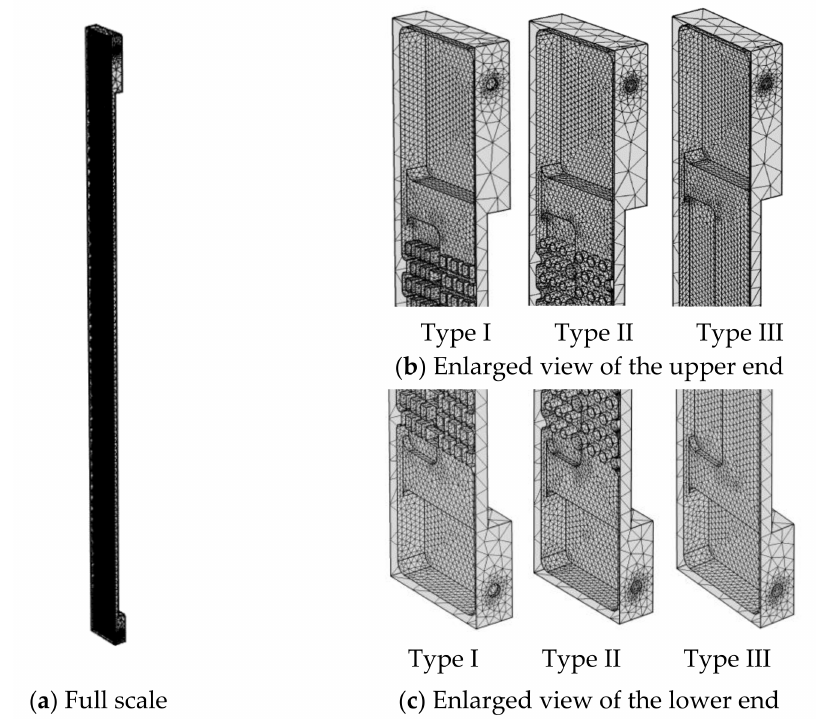
Figure 5. Internal meshes of the cold plate with fins of different